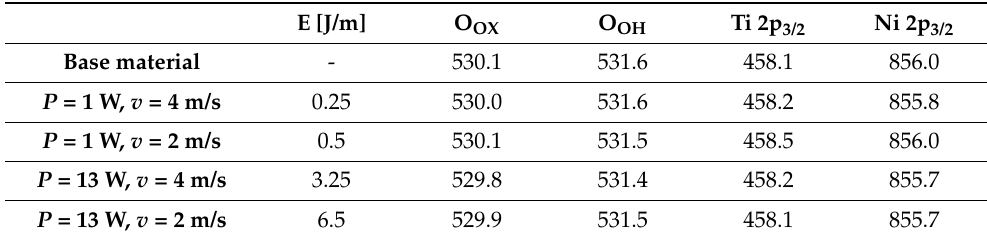
Table 3. Binding energies (eV) O1s, Ti2p and Ni2p regions. O1s photoemission peaks fitted with two components oxide (O OX ) and hydroxide (O OH ).